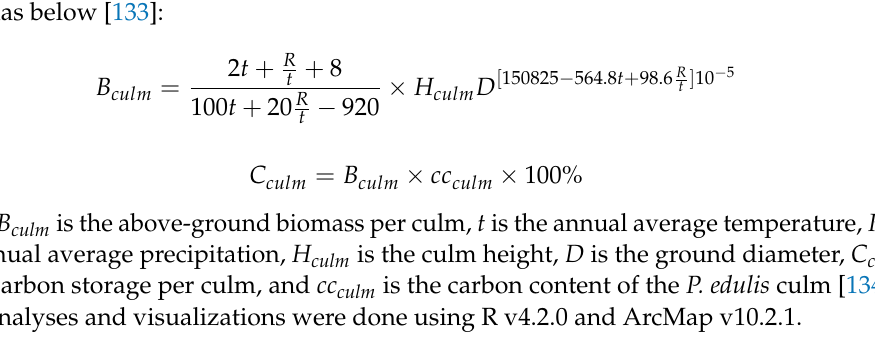
internodes. Table S3: The posterior distribution for each parameter of internode length. Table S4: The posterior distribution for each parameter of the percentage of internodes with different internode lengths (0–10 cm, 10–20 cm, 20–30 cm, 30–40 cm, 40–50 cm). Table S5: The posterior distribution for each parameter of the percentage of internodes with different lengths (0–10 cm, 10–20 cm, 20–30 cm, 30–40 cm, 40–50 cm). Table S6: The posterior distribution for each parameter of estimated biomass and carbon storage. Table S7: Monthly temperature and precipitation of each study area in